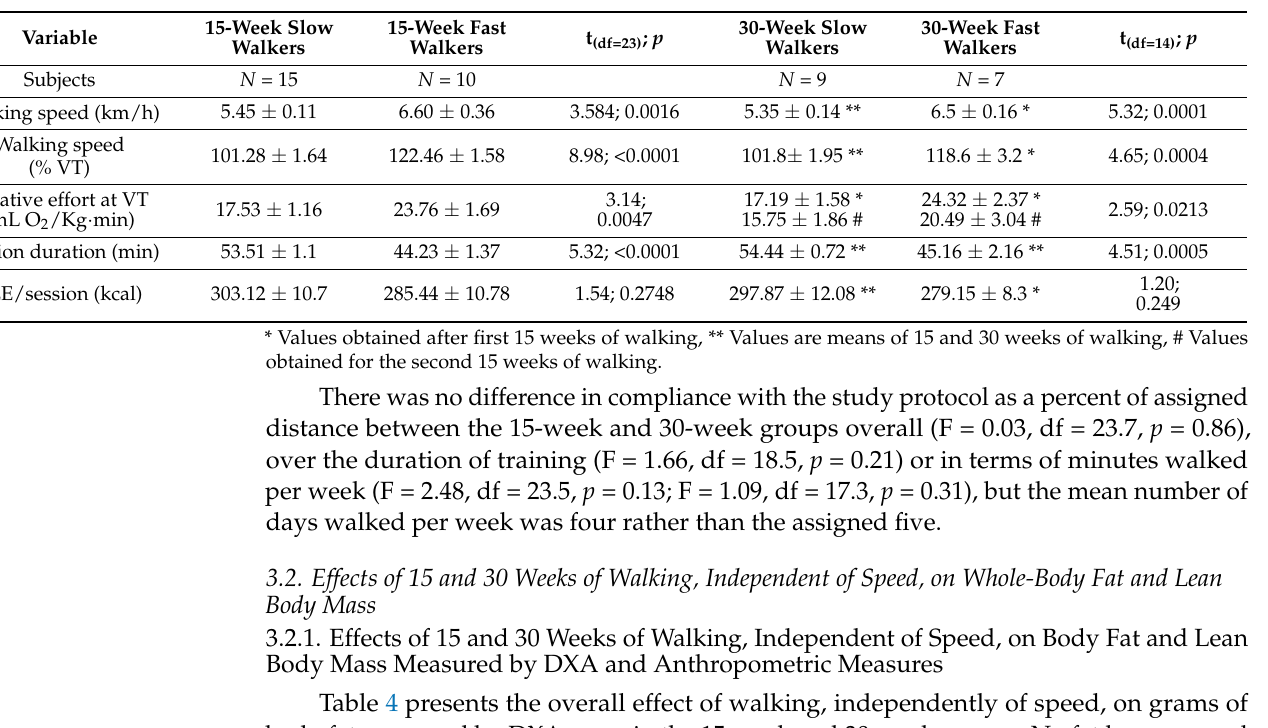
Table 3. Exercise outcomes for fast and slow subjects in 15-week and 30-week